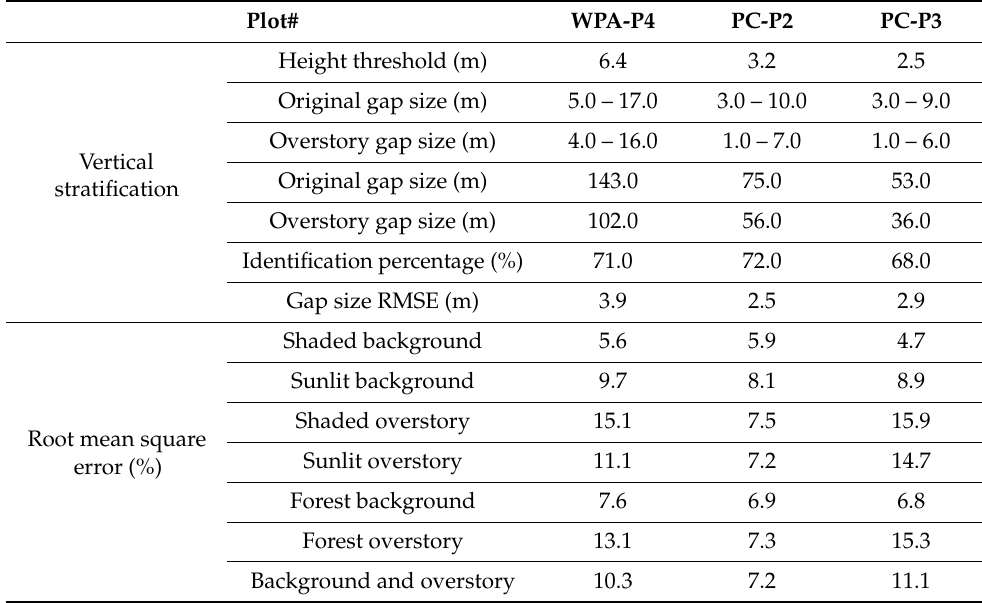
Table 4. Comparisons between the gap sizes obtained from stratified overstory and original ALS data and the root mean square errors of four forest component proportions between ALS- and 3DSmax-based in three forest plots (WPA-P4, PC-P2, and